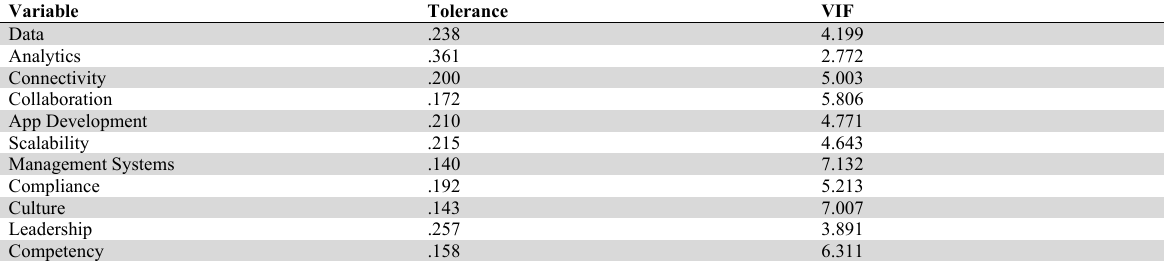
Multicollinearity